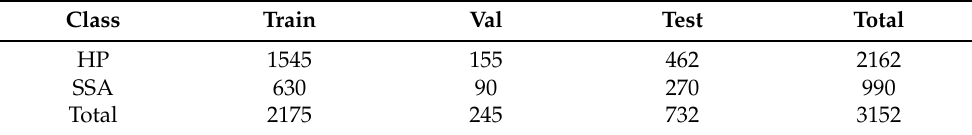
Table 2. The number of images in MHIST dataset and their partitioning into training, validation, and testing. It is clear that this is not a balanced dataset. The HP class covers 69% of the dataset.